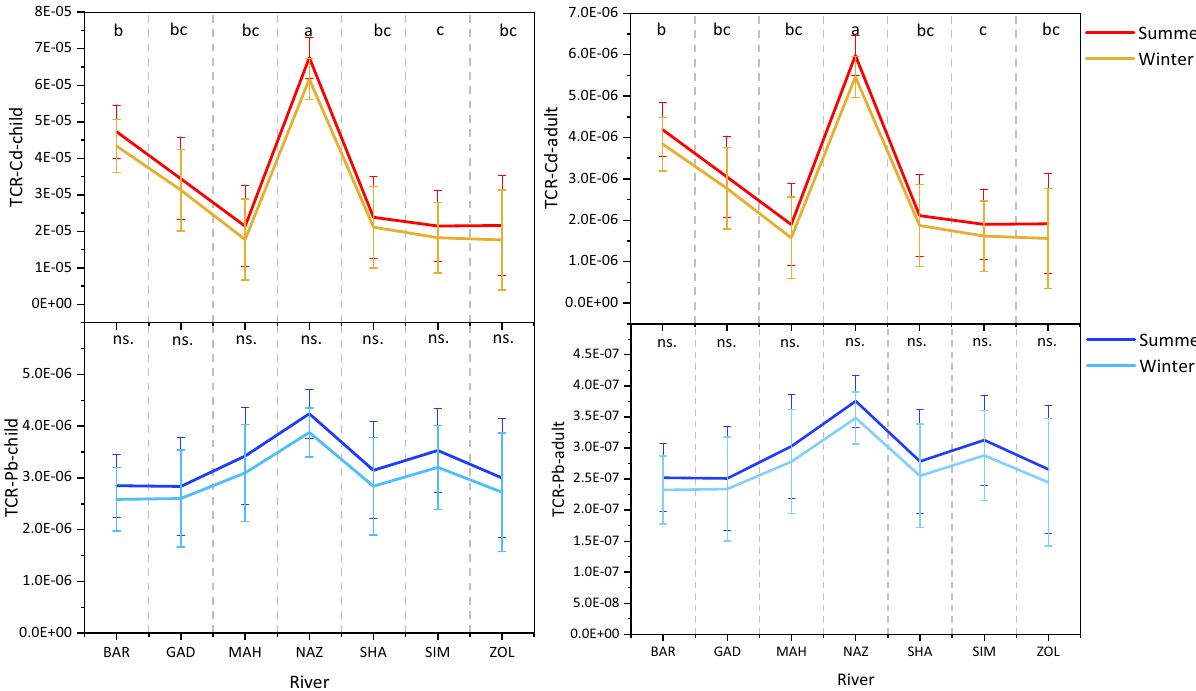
Figure 7. The comparison of the mean total carcinogenic risk (TCR) of Cd and Pb and for children and adult among the study rivers’ sediments. Different letters represent significant differences in enrichment factor among rivers pooled over seasons at P < 0.05 confidence level. ns. represents the lack of significat